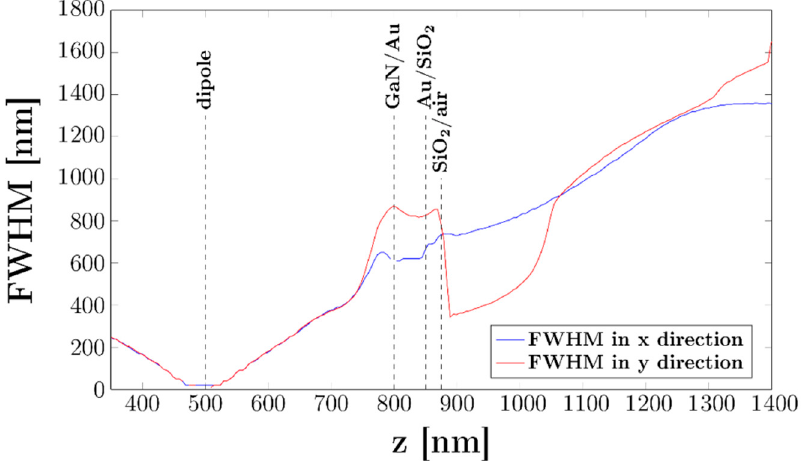
Figure 10. Full-width at half-maximum as a function of the vertical coordinate z. Dashed lines indicate the material interfaces inside the LED structure. The p-GaN layer’s thickness is equal to 300 nm.